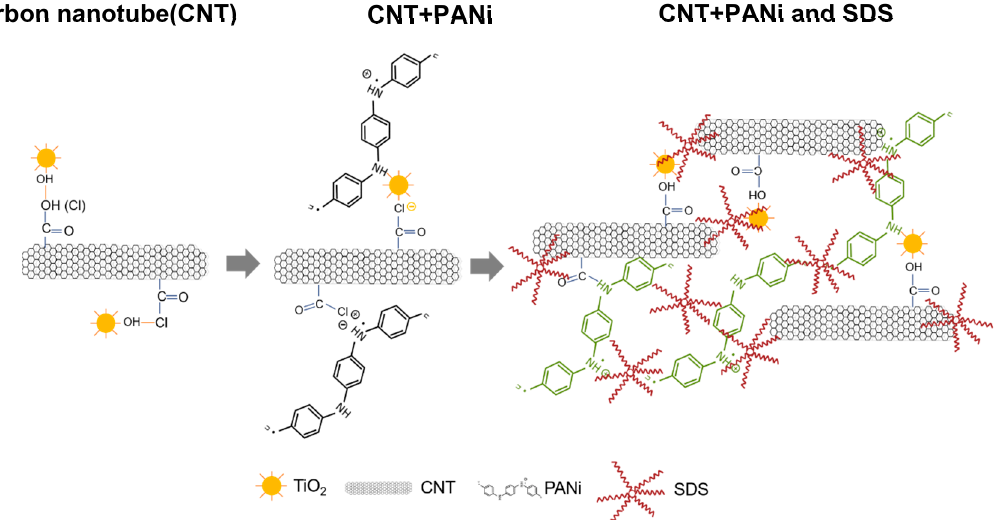
Figure 5. The proposed morphology of immobilized PANi-CNT/TiO 2 photocatalysts.